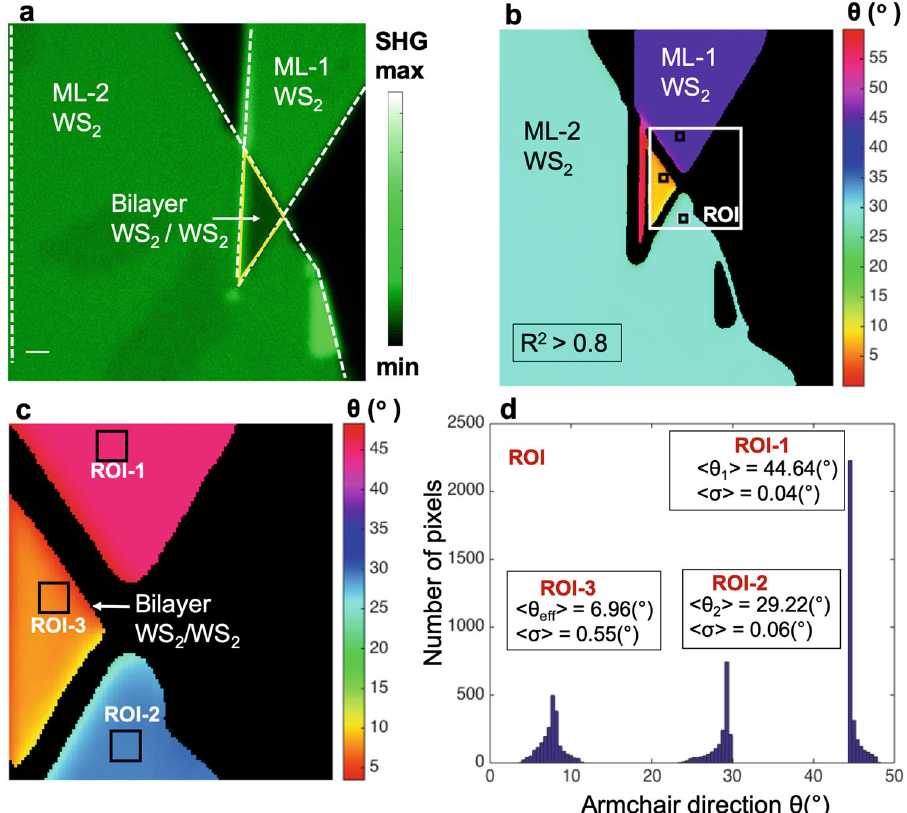
Fig. 4 Optical imaging of twist-angle in WS 2 /WS 2 bilayer. a SHG image without the use of analyzer, showing the two ML-WS 2 regions and the bilayer WS 2 /WS 2 region. We note that the bilayer region has less SHG signal than the MLs regions. Scale bar indicates 1 μ m. b Mapping of the armchair direction, obtained via pixel-by-pixel fi tting of 360 P-SHG images, one for every φ ∈ [0(°) – 359(°)], with step 1(°) and fi xed analyzer ( ζ = 0(°)) to Eq. (1). Only pixels that presented R 2 > 0,8 are kept. c Pixel-by-pixel mapping of the armchair direction for the ROI seen in ( b ). Three ROIs are de fi ned. ROIs-1,2 for the WS 2 MLs and ROI-3 inside the bilayer WS 2 /WS 2 region. d Image histogram showing the distribution of armchair directions seen in ( c ) and in the ROI seen in ( b ). The mean armchair directions and their standard deviation ( σ ) of the armchair values found in ROIs1-3 are